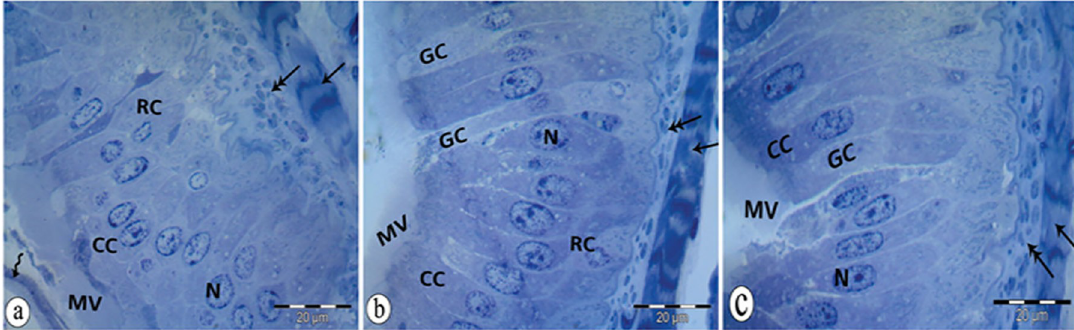
Fig 5. A semithin sections of the midgut epithelium a: circular muscle (arrow), longitudinal muscle (double head arrow), regenerative cell (RC), columnar cell (CC) nucleus (N), microvilli (MV), peritrophic membrane (wavy arrow). b: circular muscle (arrow), longitudinal muscle (double head arrow), regenerative cell (RC), columnar cell (CC), nucleus (N), goblet cell (GC), microvilli (MV). c: circular muscle with light and dark bands (arrow), longitudinal muscle (double head arrow), columnar cell (CC), nucleus (N), goblet cell (GC), microvilli